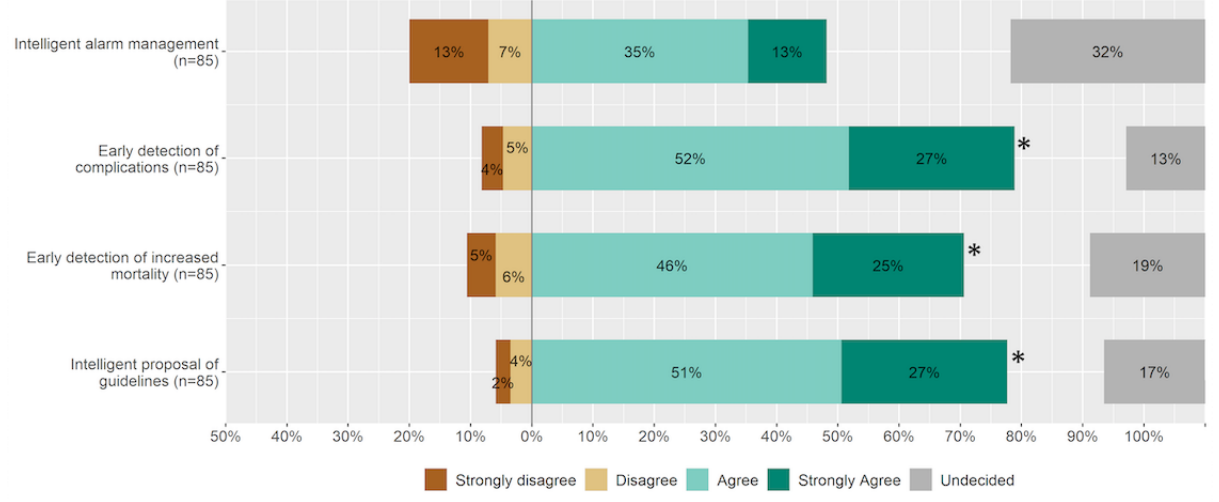
Figure 7. Aspects that promote the usage of clinical decision support systems based on artificial intelligence in the ICU. An asterisk indicates statistical significance. ICU: intensive care